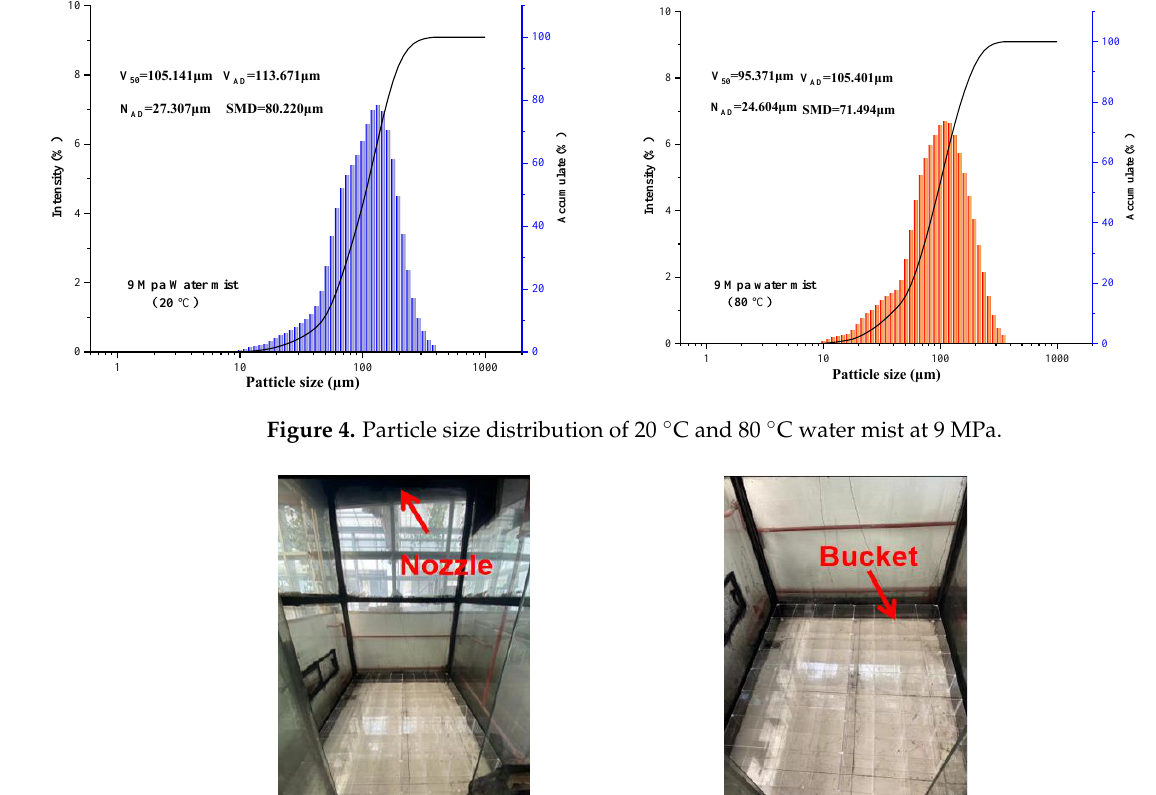
Figure 3. Particle size distribution of 20 °C and 80 °C water mist at 3 MPa.